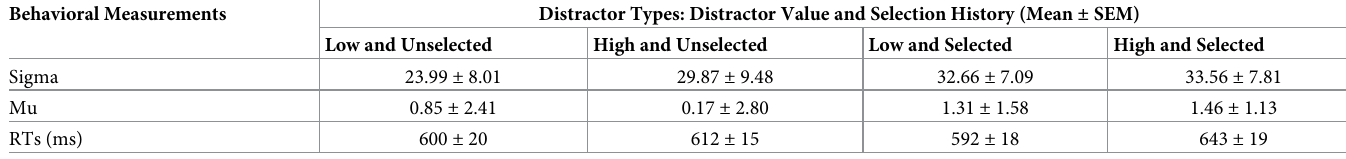
Table 1. Cumulative Gaussian best-fit variables describing choice preference data and RTs for different distractor types shown in Fig 2. Behavioral